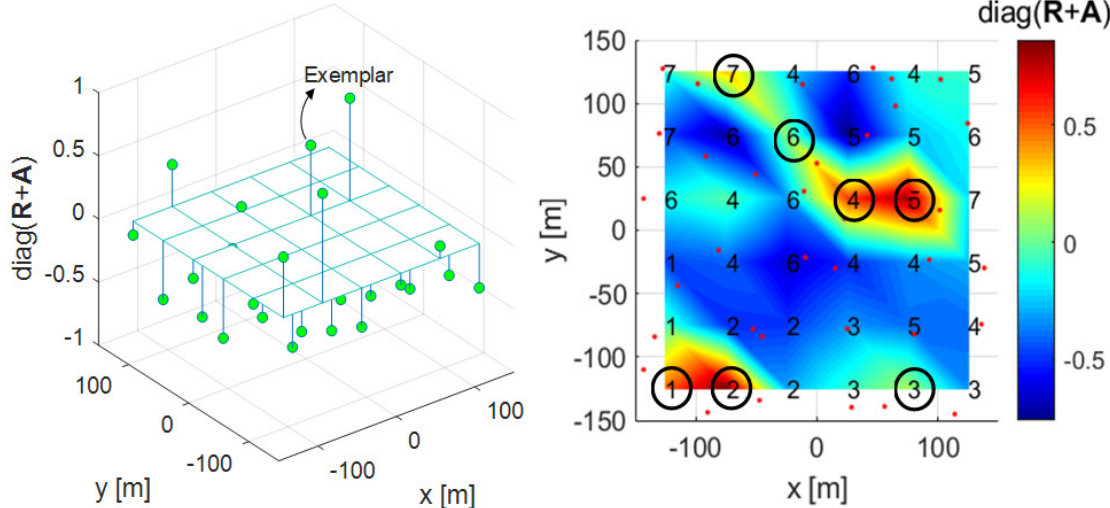
Figure 5. 3-D plot (left) and mesh plot (right) with the diagonal components of the R + A in Algorithm 1.